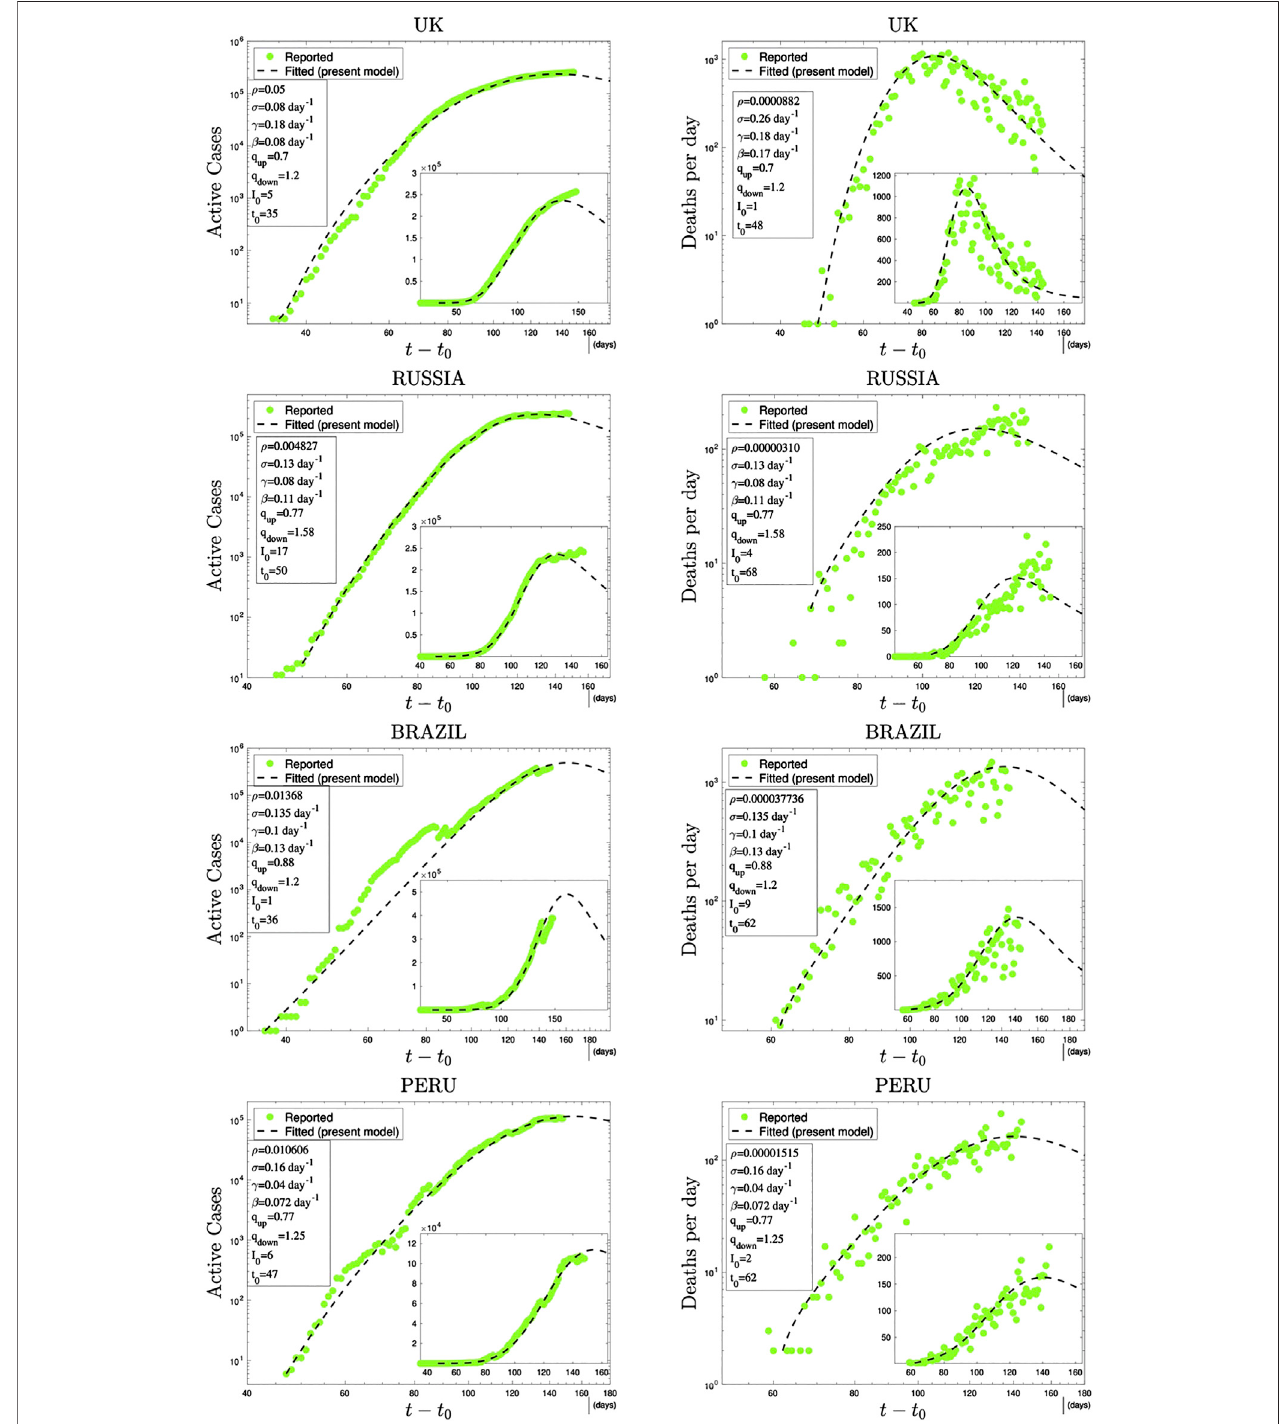
FIGURE 4 | Continuation of Figure 3